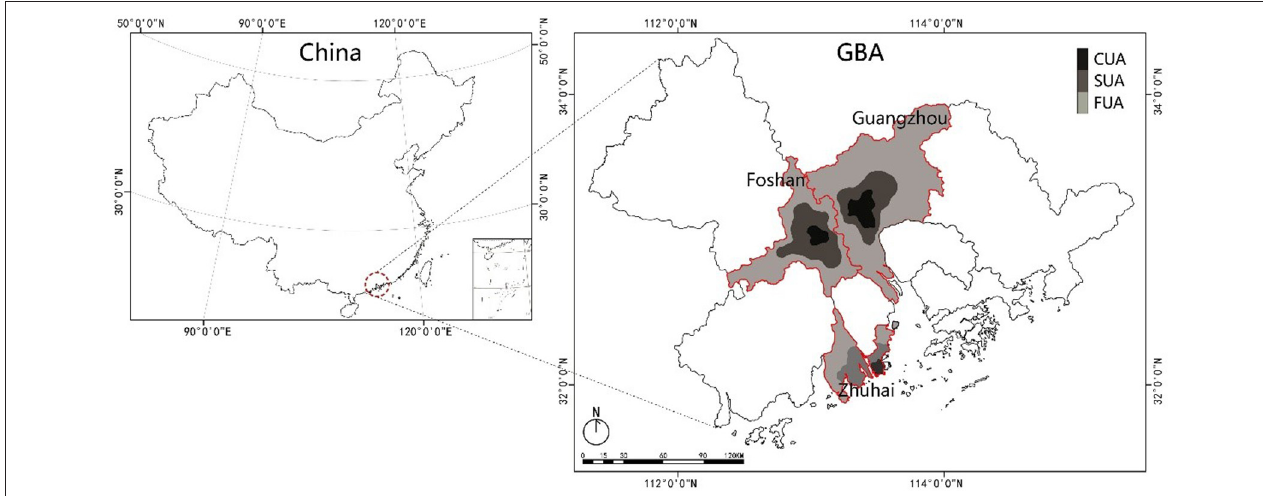
FIGURE 1 | Schematic of the locations of the three surveyed cities - Guangzhou, Foshan, and Zhuhai in Guangdong-Hongkong-Macau Greater Bay Area (GBA), China. The areas with the colors dark gray, medium gray and light gray in each city represent core urban area (CUA), semi urban area (SUA) and urban fringe area (UFA), respectively.